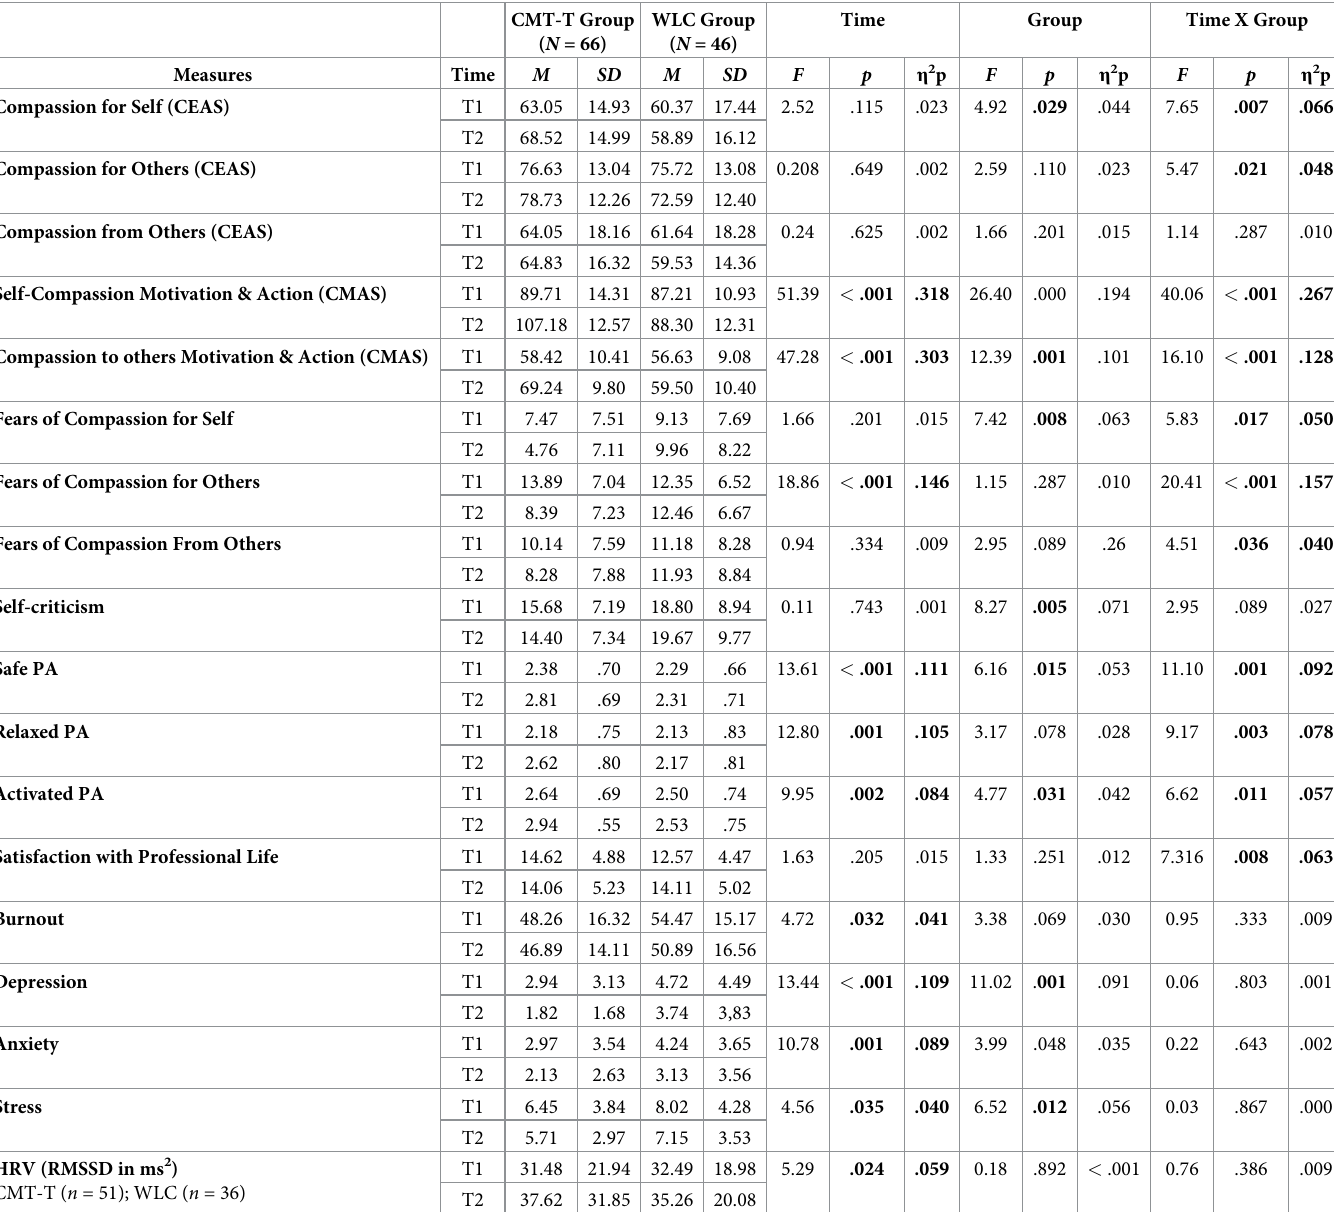
Table 3. Means, standard deviations before (T1) and after (T2) the CMT-T, time main effect, group main effect and time group interaction effect.